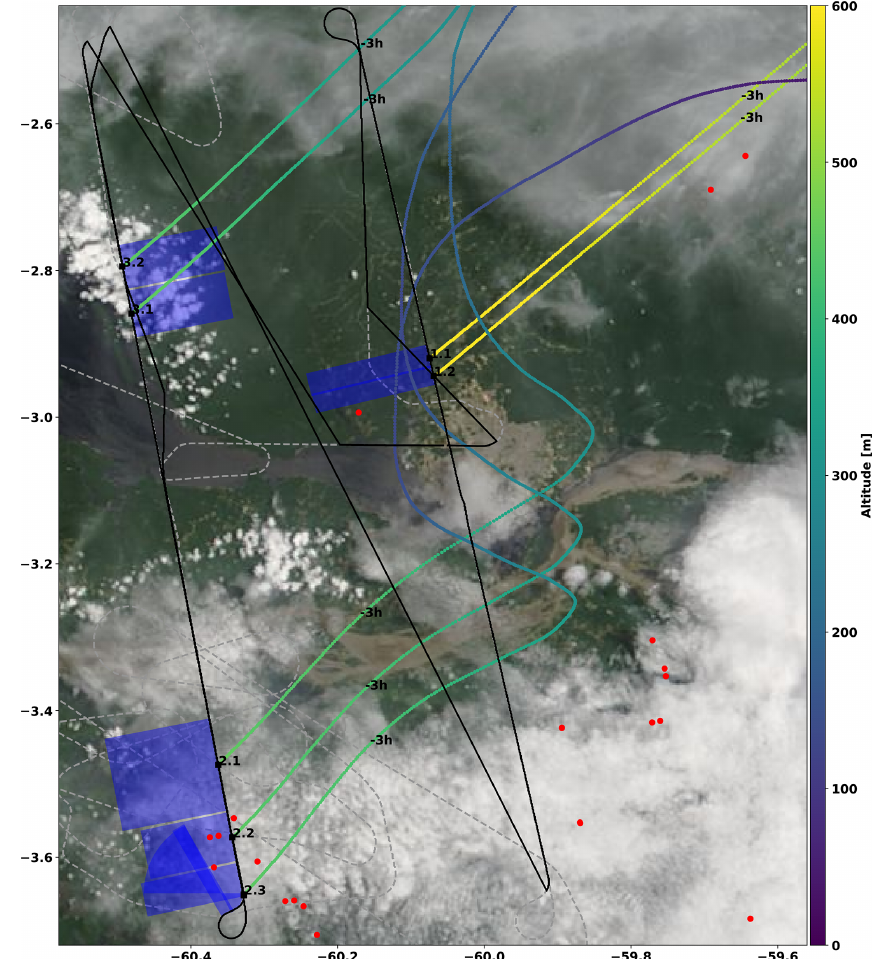
Figure 6. Zoom of the flight track for AC11 on 16 September 2014. The flight tracks below and above 1000m altitude are labelled by drawn and dashed lines, respectively. The take-off and landing of the aircraft was from Manaus airport (3.1 ◦ S, 60.0 ◦ W) located in the centre of the image. The biomass burning events detected by the MCD14 MODIS instrument on the Terra and Aqua satellites are indicated with red dots (not to scale). The biomass events probed by the mini-DOAS instrument are marked by black numbers next to the flight track, according to the labelling of Table 3. The blue rectangles approximately indicate the probed air masses in the horizontal plane, where the distance perpendicular to the flight track is given by the O 4 estimated photon path lengths (14 to 19km) and the along-track distance (3 to 15km) by the spectrum integration time (33 to 166s) multiplied by the aircraft ground speed (approximately 95ms − 1 ) (Sect. 2.1). For each biomass burning event, 3h backward air mass trajectories were calculated and plotted colour coded by the altitude of the air mass. The MODIS satellite image was taken from NASA WORLDVIEW; see https://worldview.earthdata.nasa.gov/ (last access: 16 October